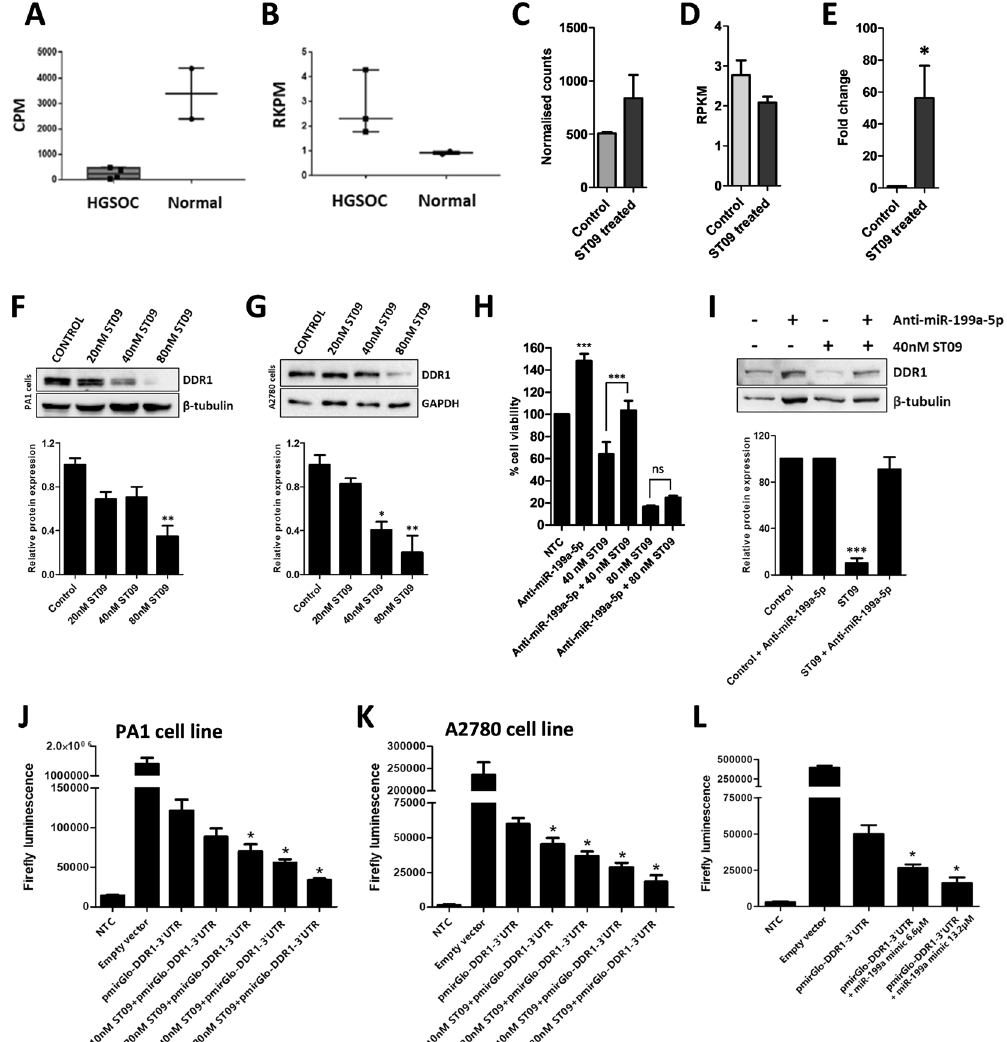
Figure 4. Negative correlation of DDR1 and miR-199a-5p in ovarian cancers and DDR1 is a direct target of miR-199a-5p. ( A ) mir-199a-5p expression in Indian HGSOC samples. ( B) DDR1 expression in Indian HGSOC samples. ( C) Bar graph depicting miR-199a-5p expression in ST09 treated PA1 cells where y-axis represents normalised counts obtained from miRDeep2 tool ( D) Bar graph depicting DDR1 expression (in RPKM) in ST09 treated PA1 cells. ( E) Represents mir-199a-5p expression in 40 nM ST09 treated PA1 cells by qPCR. ( F) Expression and quantification of DDR1 protein in PA1 cells treated with increasing concentrations of ST09 for 48 h. ( G) Expression and quantification of DDR1 protein in PA1 cells treated with increasing concentrations of ST09 for 48 h. ( H) MTT assay of PA1 cells transfected with/without anti-miR-199a-5p (2.5 nM) and ST09. ( I) Expression and quantification of DDR1 protein in PA1 cells transfected with/without anti-miR-199a-5p and 40 nM ST09. ( J) Bar graph quantification of luciferase activity upon transfecting PA1 cells with pmirGlo- DDR1-3’UTR with increasing concentrations of ST09. ( K) Bar graph quantification of luciferase activity upon transfecting A2780 cells with pmirGlo-DDR1-3’UTR with increasing concentrations of ST09. ( L) Bar graph quantification of luciferase activity upon transfecting HEK293 cells with pmirGlo-DDR1-3’UTR in combination with miR-199a-5p mimic (6.6 and 13.2 µM). The luciferase activity is represented as the relative fluorescence intensity of firefly luminescence. Uncropped gel images are provided in the supplementary information. All bar graphs are plotted as mean ± SD from three independent experiments. Significance was plotted based on p values, and represented as *( p -value < 0.05), **( p -value < 0.01), and ***( p -value <